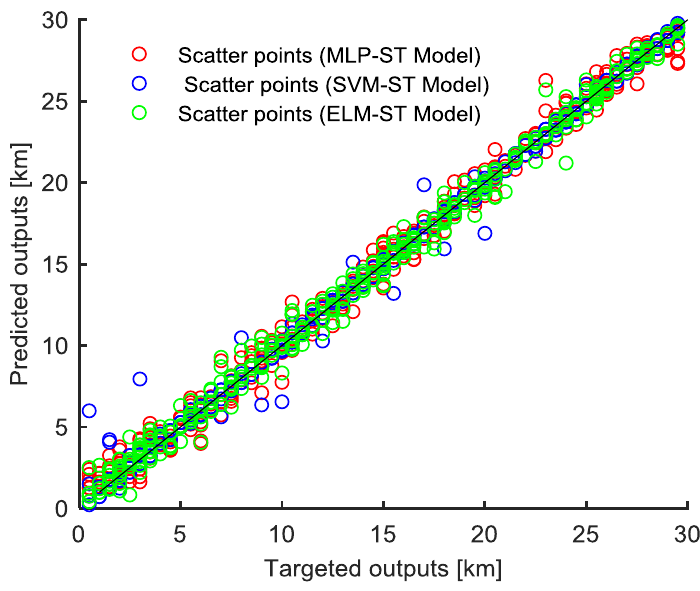
Figure 11. Scatter plot of the targeted and the ST based optimized MLT predicted outputs, for the test dataset, in the presence of 20 dB SNR. Table 7. Operation time and the statistical performance indices, for the test datasets with CF-PSO optimized MLT, in the presence of 30 dB SNR.